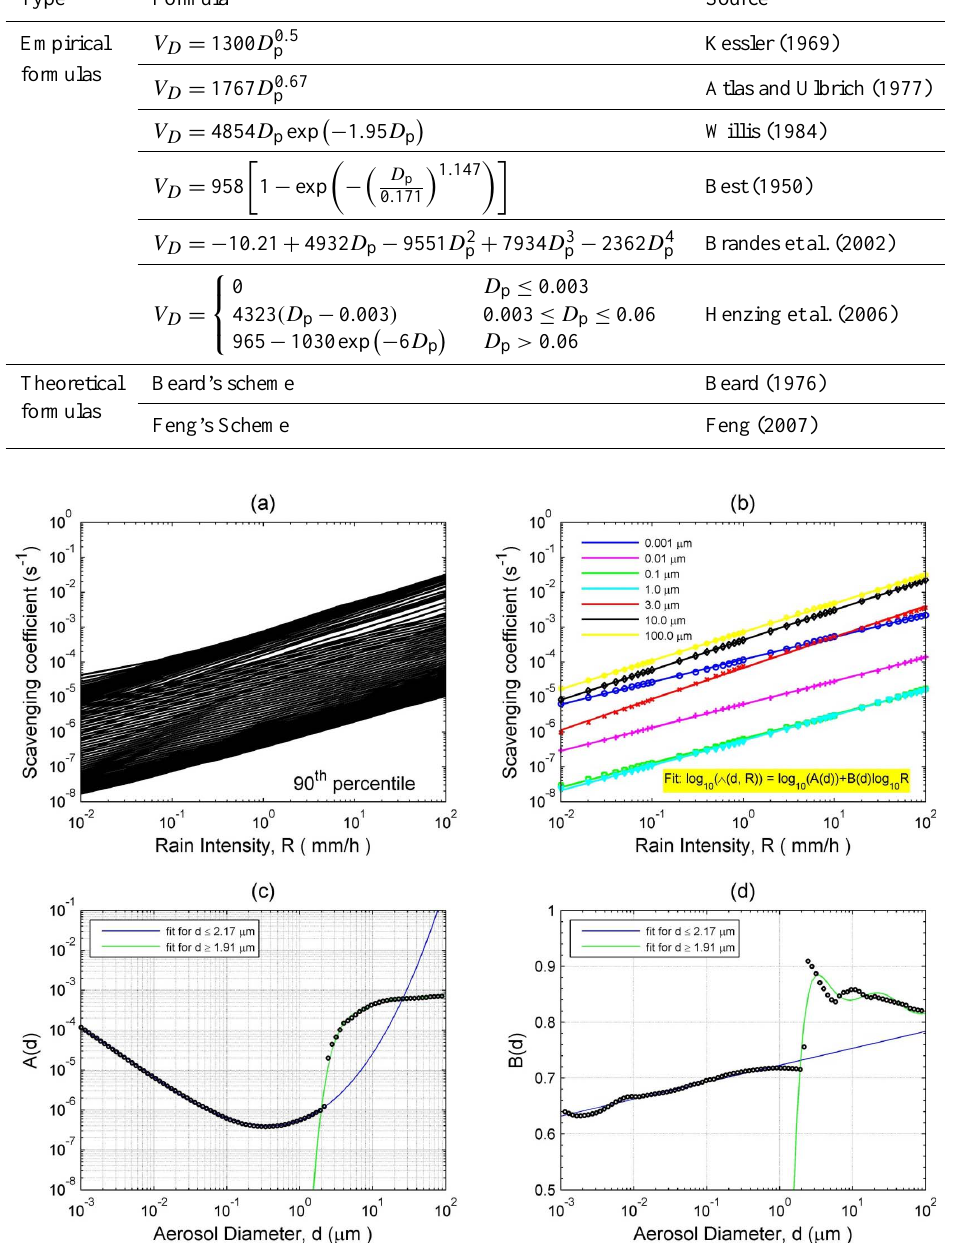
Fig. 2. (a) 90th-percentile 3 rain profiles as a function of precipitation intensity R derived from an ensemble of 320 3 rain realizations for 100 particle diameters (a total of 100 lines); (b) linear regression best-fit lines for the 90th-percentile 3 rain data (symbols) from (a) for seven aerosol particle diameters; (c) values (symbols) of y intercept A(d) from the log-linear regressions for 100 particle diameters and their polynomial best-fit curves (lines); and (d) same as in (c) but for the slope B(d) of the log-linear regressions.